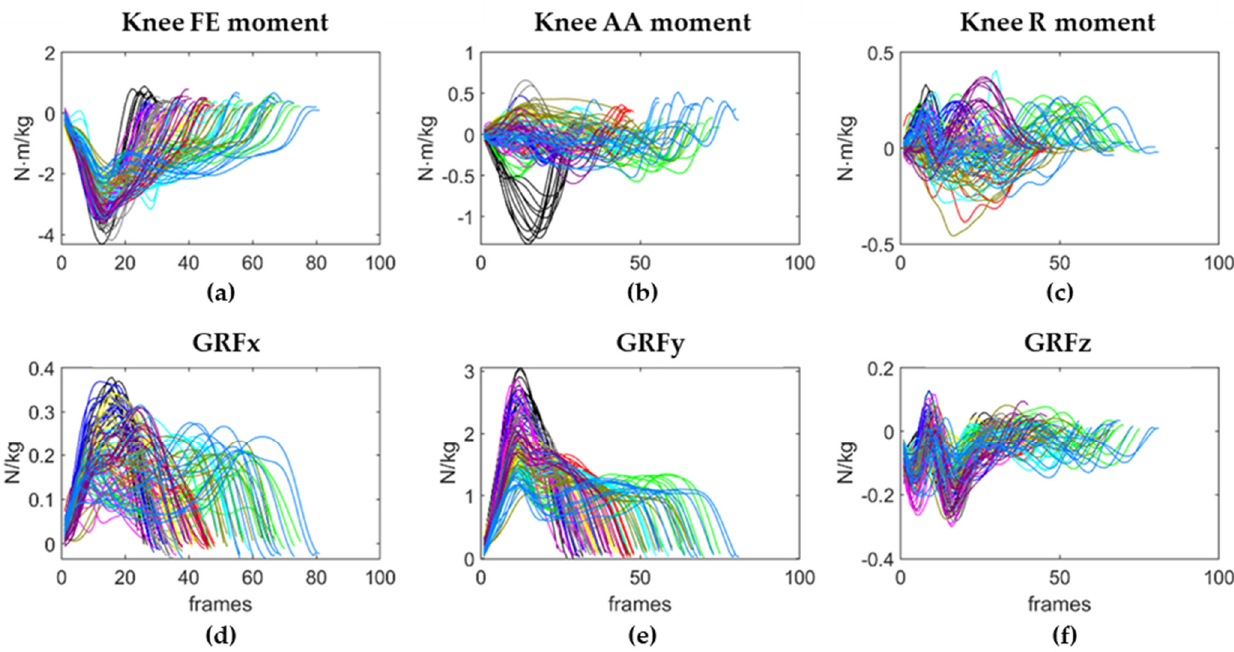
Figure 6. Right knee joint moments ( a – c ) and right GFRs ( d – f ) during the 112 VDJs. The number of frames that composes each VDJ is highly variable, depending on the jumping behavior of the subjects. Each color corresponds to the VDJs performed by a subject.